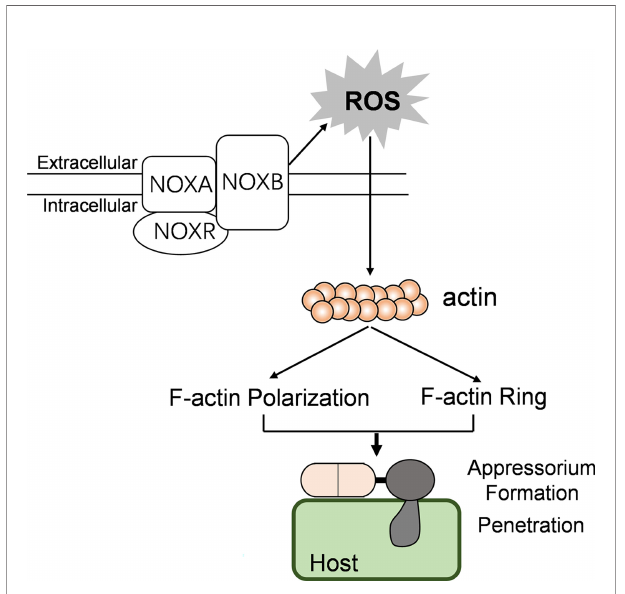
FIGURE 9 | The possible model showing the relationships between NOX, F-actin organization, and pathogenicity in C. gloeosporioides